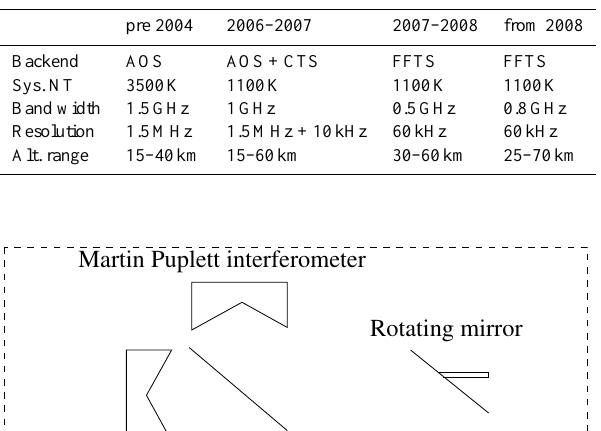
Table 1. Summary of OZORAM characteristics. The altitude range and altitude resolution depend on integration time. The figures given here correspond to a measurement interval of 1h. For the difference in altitude range refer to Sect. 2.2. Data recorded until 2004 have been used in past publications (Sinnhuber et al., 1998; Klein et al., 2000, 2002) and are listed here for completeness.